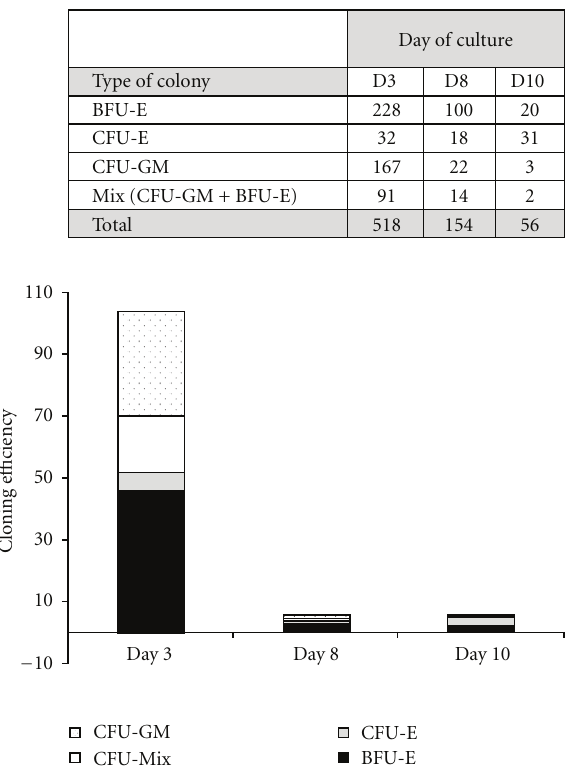
Figure 2: Colony formation of FL-derived erythroid cells. The colony forming ability of FL-derived erythroid cells was measured on days 3, 8, and 10 of liquid culture. Aliquots of nonadherent cells were grown in methylcellulose medium in the presence of SCF, GM-CSF, IL3, and erythropoietin. CFU-E colonies were counted on day 7 and BFU-E, CFU-GM, and CFU-mix colonies on day 14 of semisolid